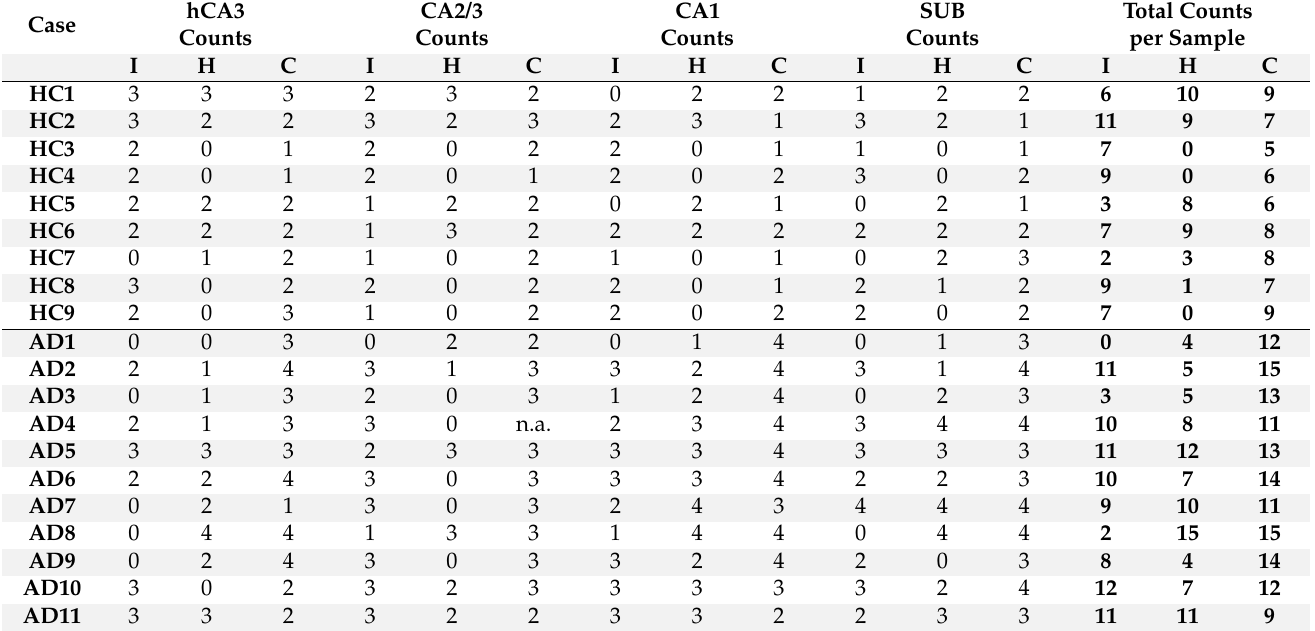
Bold numbers represent totals from the individual subdivisions.